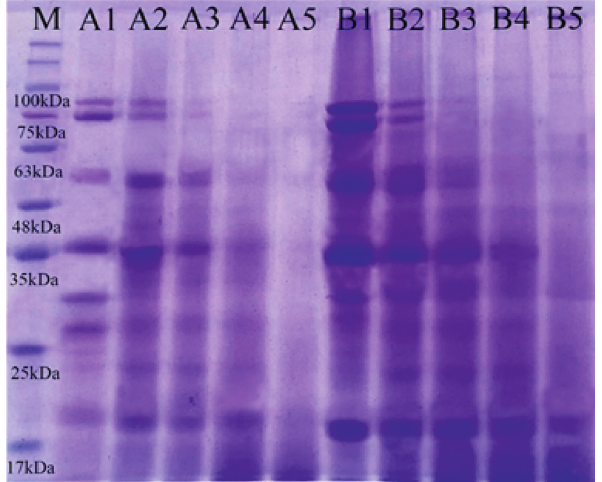
Figure 7: SDS-PAGE patterns of different samples (SPINA1–A5 (0, 1, 2, 4, and 8 h); SPIHNB1–B5 (0, 1, 2, 4, and